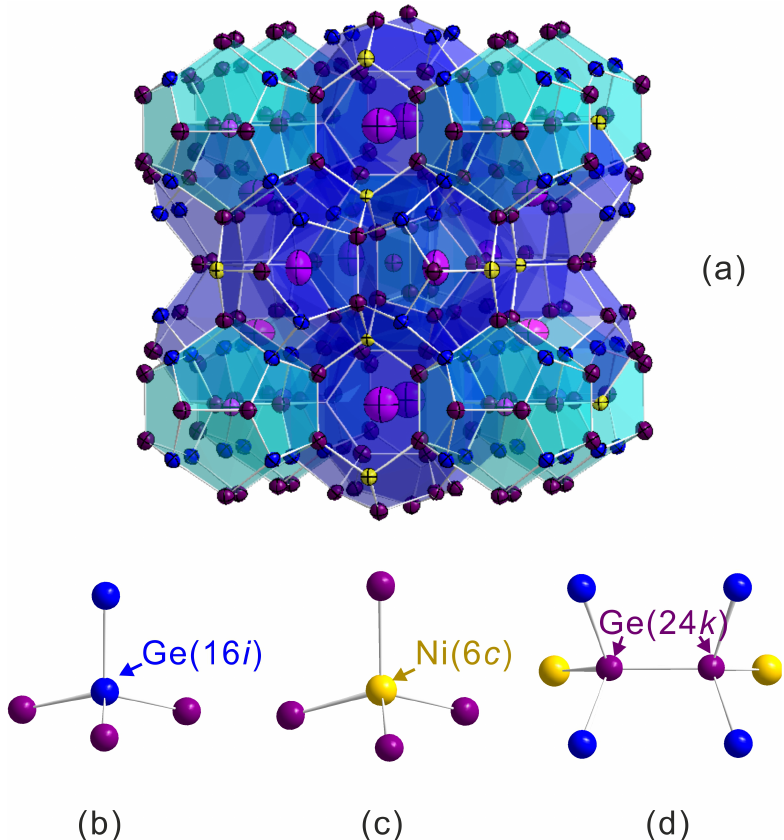
Figure 4. Crystal structure of type-I clathrate ( a ) and atomic environment (tetrahedral bonds) in different sites ( b ) Ge(16 i ); ( c ) Ni(6 c ); and ( d ) Ge(24 k